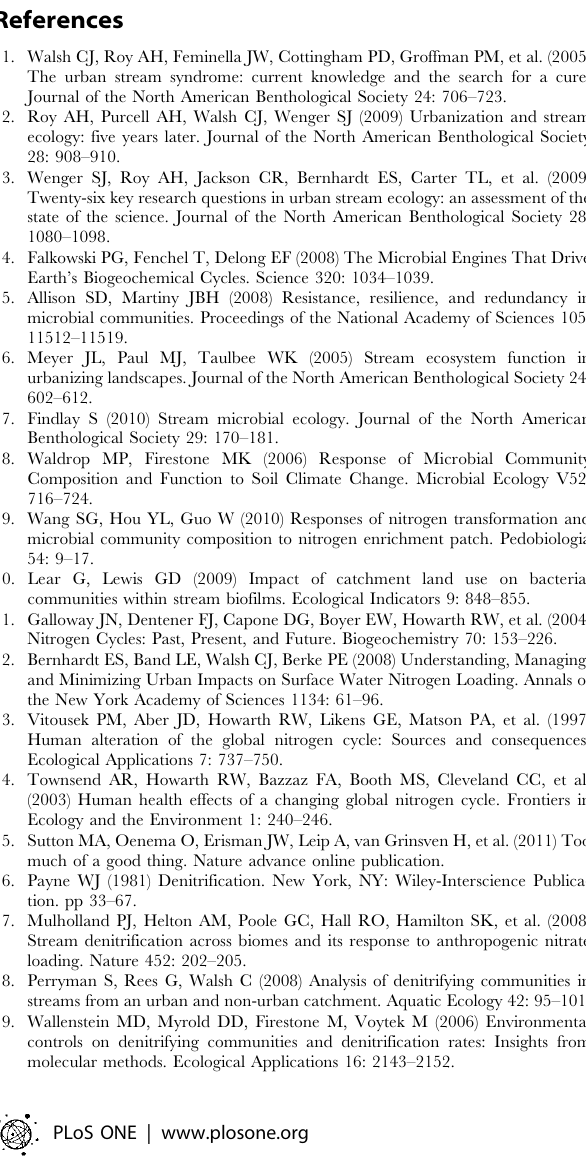
Table S4 Denitrification potential. Table S5 Non-significant terms deleted from the complete version of the first linear mixed-effects model of log-denitrification (without interaction terms). Table S6 Non-significant terms deleted from the complete version of the first linear mixed-effects model of log-denitrification (with interaction